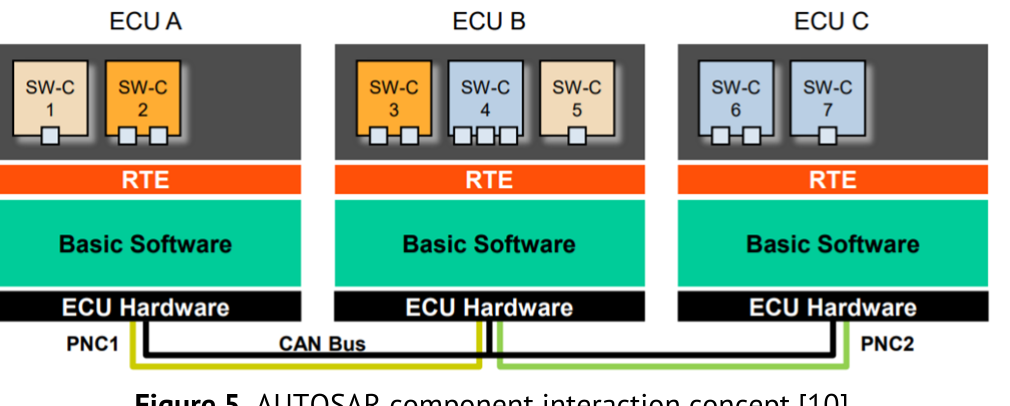
Figure 5. AUTOSAR component interaction concept